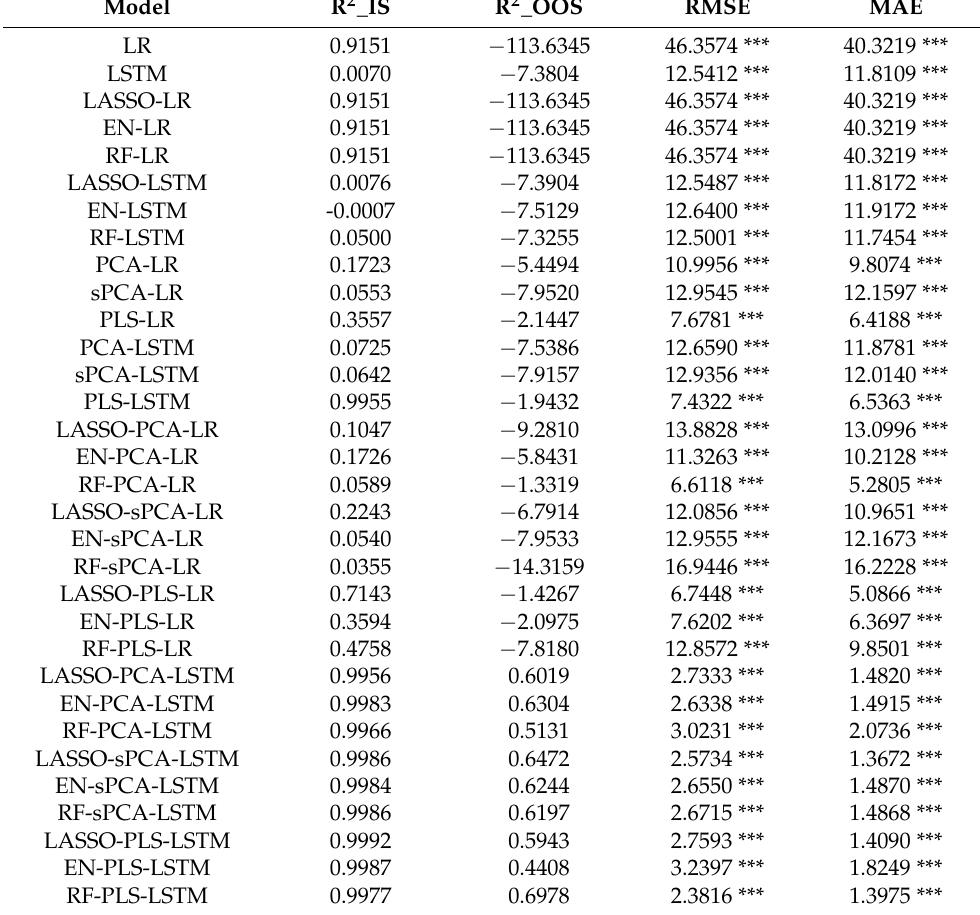
Table 11. Forecast results for